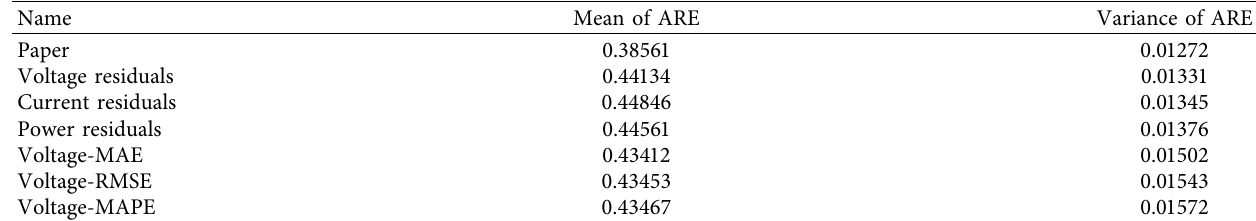
Table 3: Based on diferent loss functions, the results of parameter identifcation. Name Mean of ARE Variance of